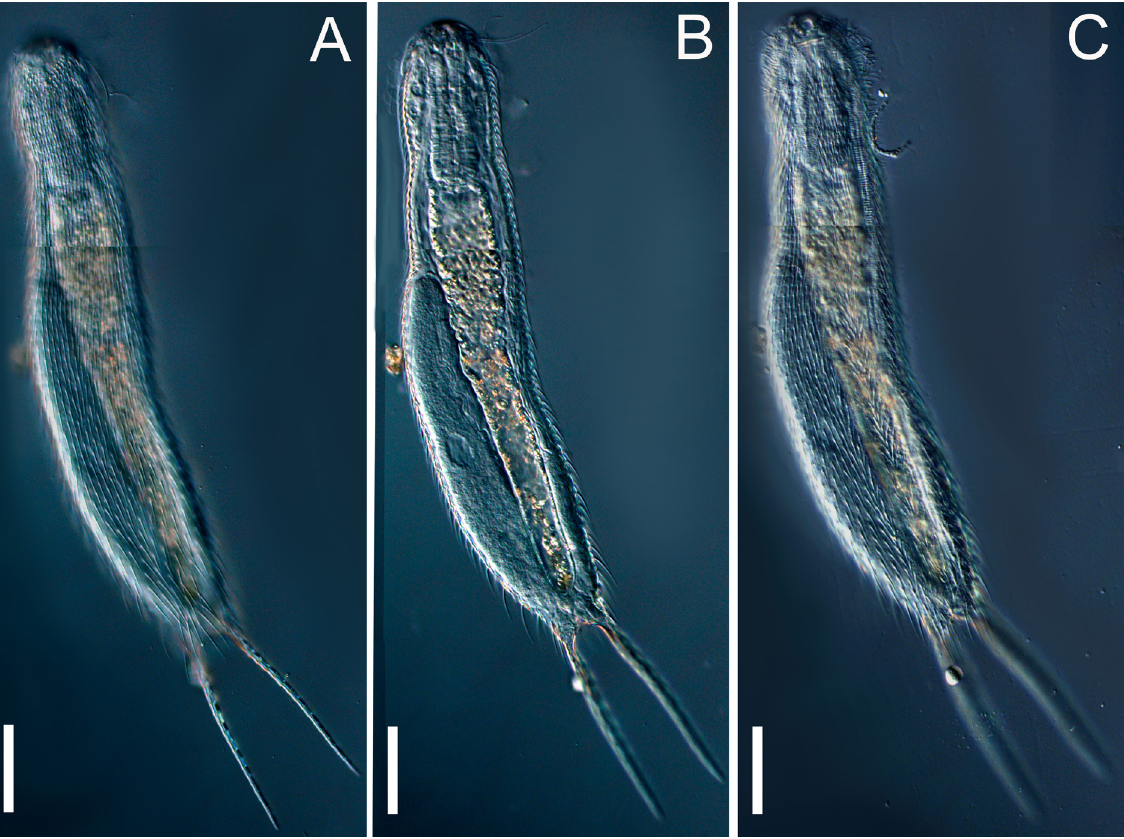
Fig. 2. Light microscopy – DIC. Polymerurus insularis sp. nov., holotype (ZUEC GCH 55). Full body view. A . Dorsal view. B . Internal view. C . Ventral view. Scale bars = 30